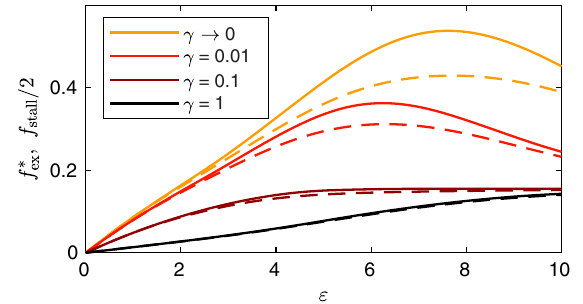
FIG. 8. Optimal external force f (cid:4) (solid lines) leading to the ex maximal extracted power (shown in the bottom panel in Fig. 3). For small external forces within linear response, this force is half the stall force f at the respective parameters (dashed lines); stall deviations occur for stronger